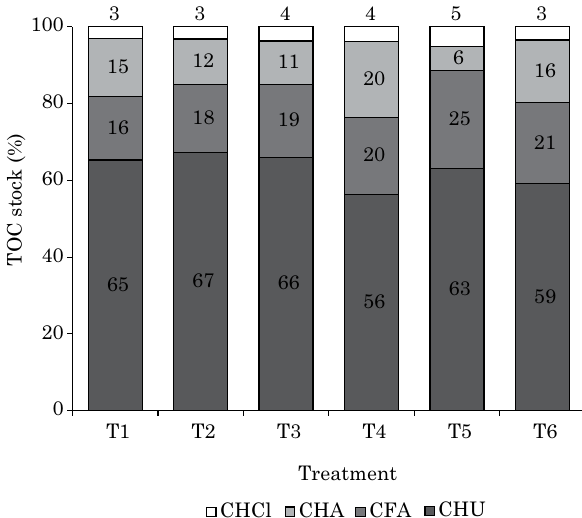
Figure 1. Proportion of chemical fractions in relation to the total soil organic carbon stock (tOC) in the 0.00-0.03 m layer of a constructed soil under cover crops, a bare constructed soil and a natural soil in a